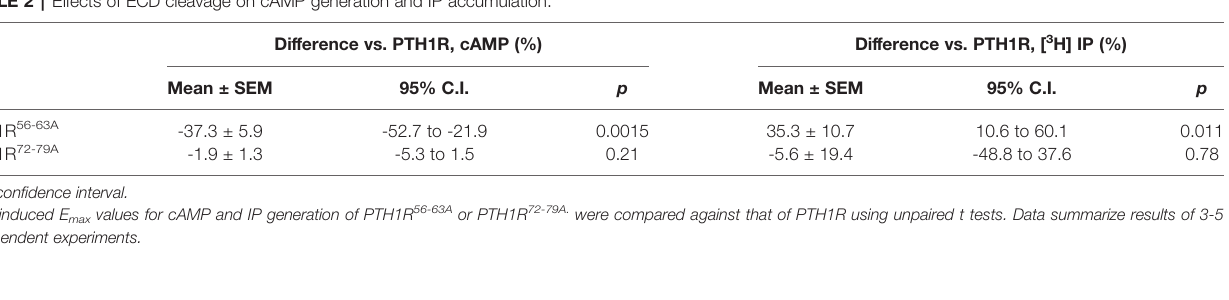
TABLE 2 | Effects of ECD cleavage on cAMP generation and IP